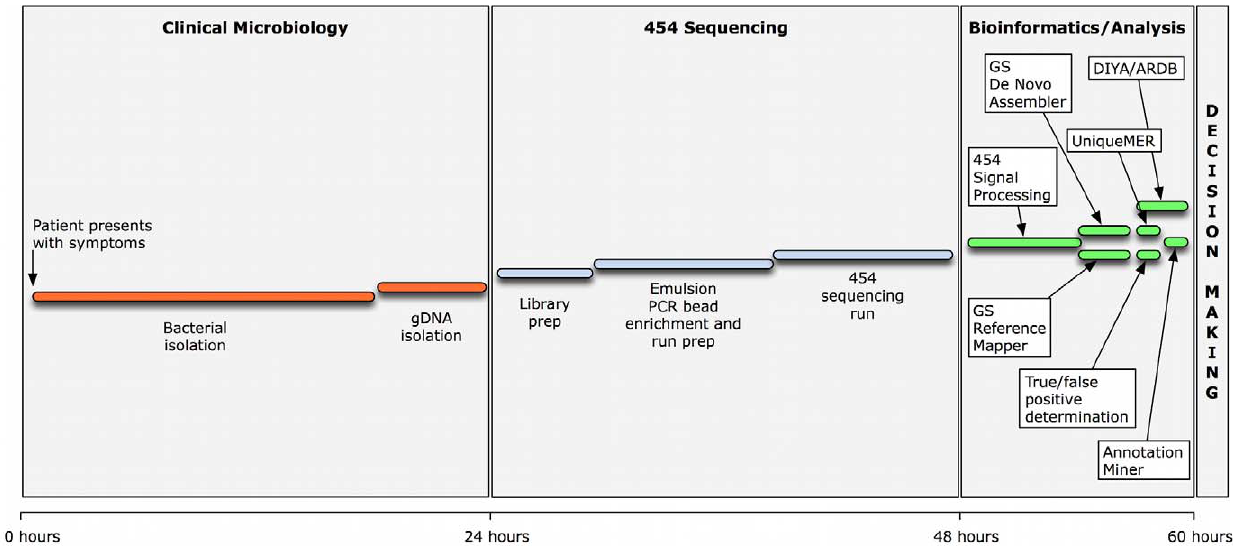
Figure 4. Proposed pipeline for rapid identification of genetic modifications in B.anthracis . The three stages involved in genetic characterization of B. anthracis in a rapid response scenario. The first day is needed for isolation of the organism from the patient and extraction of genomic DNA. During the second day WGS will be performed using Roche 454 technology. The third day is needed to analyze the genome sequence data and figure out genetic modifications. The various bioinformatics tools used in this work are